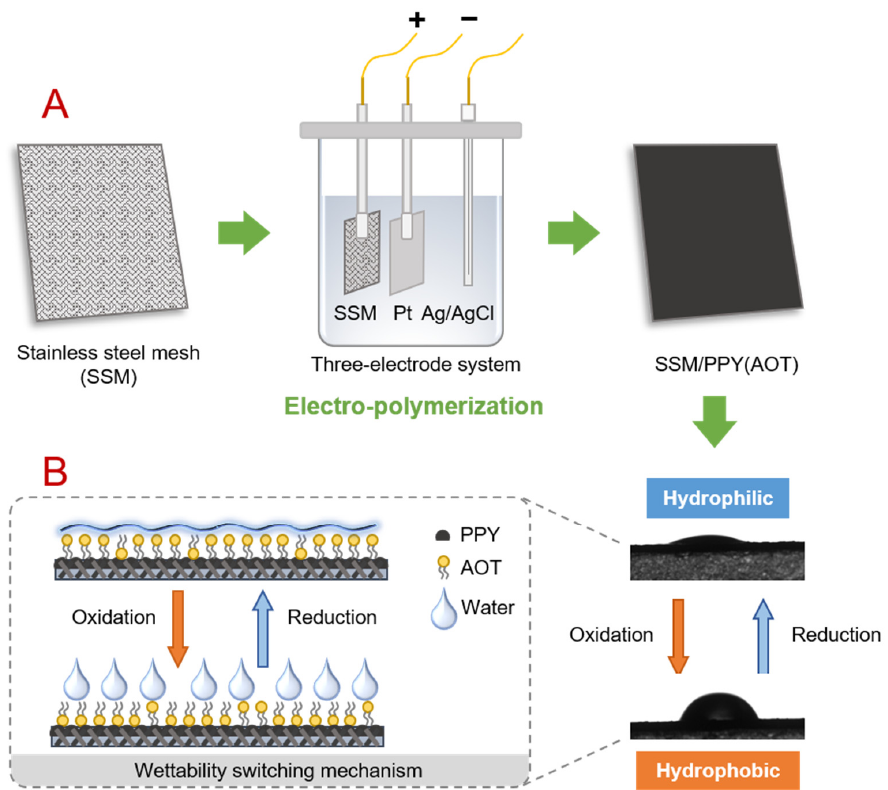
Figure 1. ( A ) Schematic protocol for the preparation of the SSM/PPY(AOT) membrane via electro- polymerization. ( B ) Illustration of the wettability switching behavior and the mechanism of the SSM/PPY(AOT) membrane.